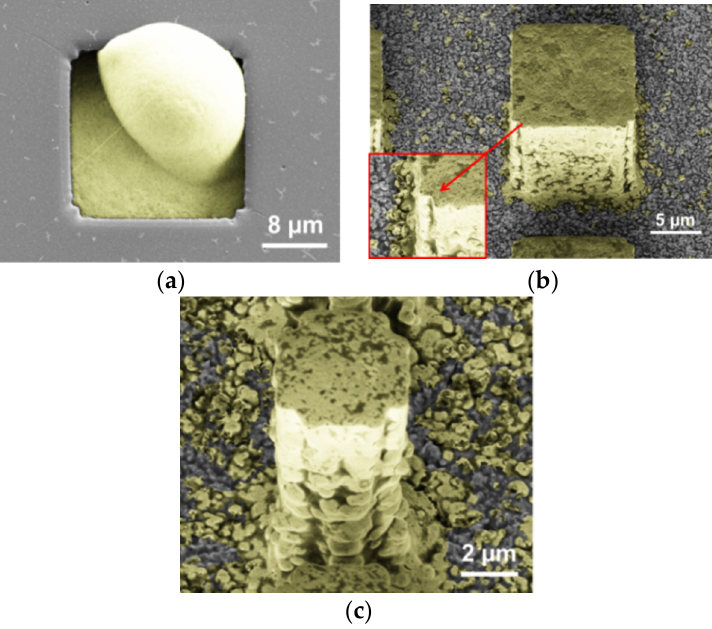
Figure 5. SEM images of the gratings chosen to test the robustness of the characterization algorithm by radiographic projection analysis: ( a ) the illustration of the gold overplating (grating before photoresist stripping); ( b ) illustration of pattern impurity and shape distortion caused by diffraction limit; and ( c ) large particle formation during electroplating.